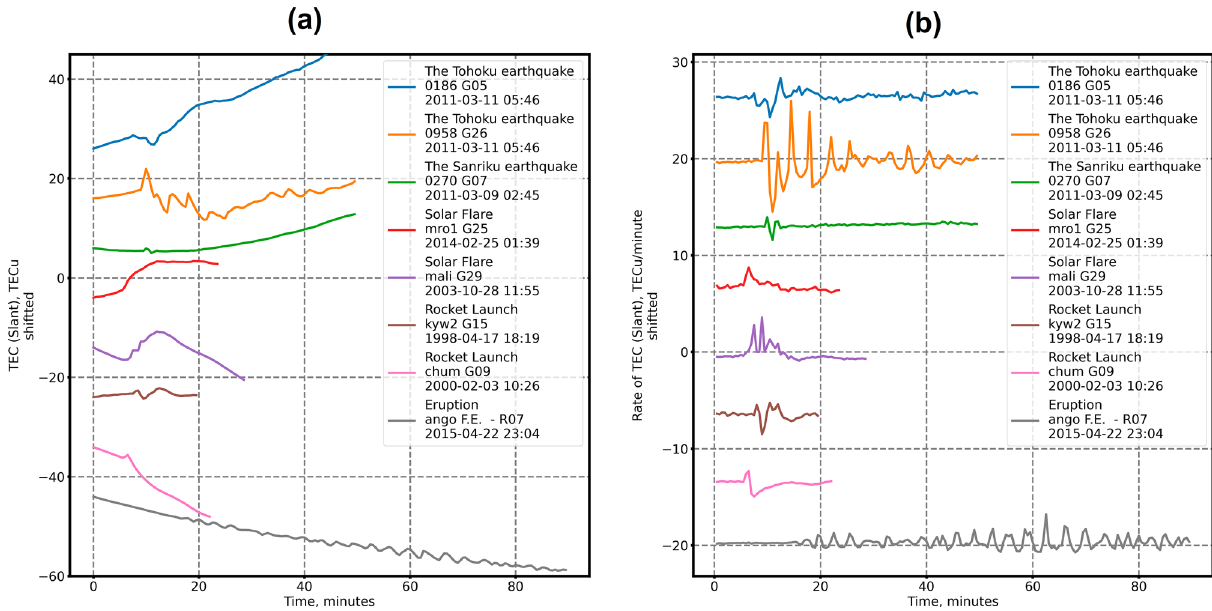
Figure 12. Examples of TEC disturbances of different origin that are detectable by our approach. Panel ( a )— slant TEC values characterized by high changes, panel ( b ) — rate of TEC of the exact data